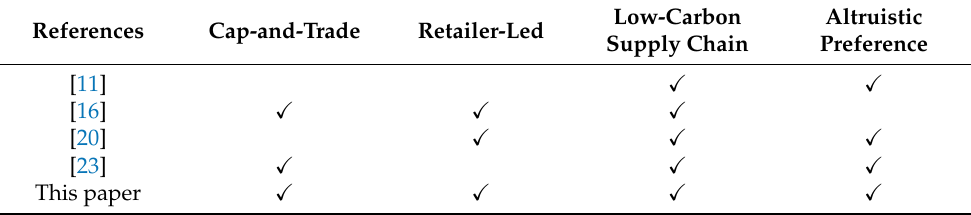
Table 1. The differences between the existing literature and our